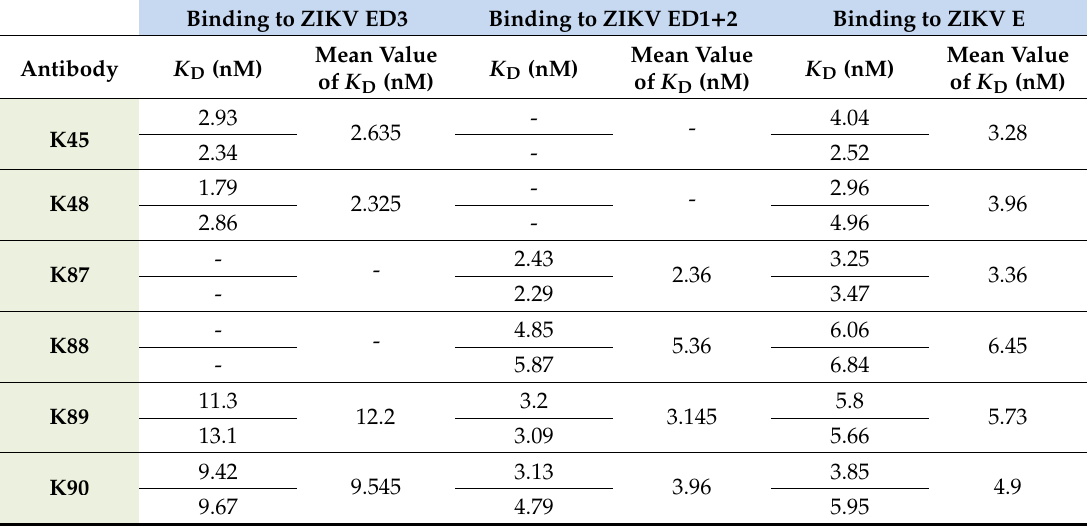
Table 5. K D values for the binding of the purified antibodies to the di ff erent ZIKV E domains. Binding to ZIKV ED3 Binding to ZIKV ED1 + 2 Binding to ZIKV E Mean Mean Value Antibody K D (nM) of K D (nM)